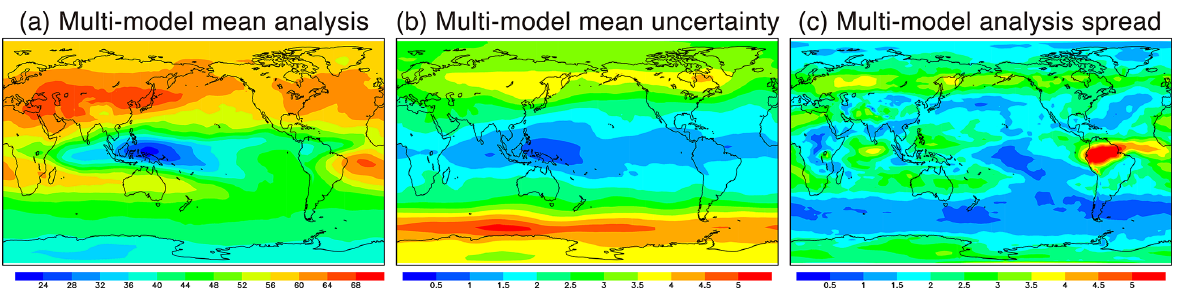
Figure 3. Spatial distributions of the multi-model mean values of (a) data assimilation analysis and (b) its uncertainty of annual mean ozone at 500hPa estimated using Eqs. (10) and (11), respectively. Panel (c) shows the standard deviation (i.e., multi-model spread) of the annual mean ozone analysis among the four